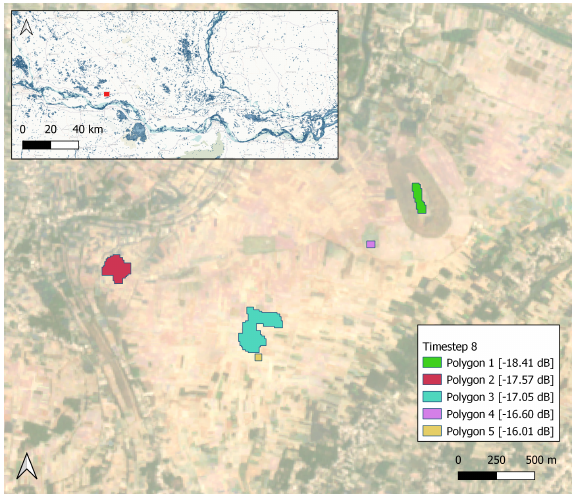
Figure 7. Detail for timestep 8 of entity depicted in Figure 6 showing the 5 different polygons and their respective mean